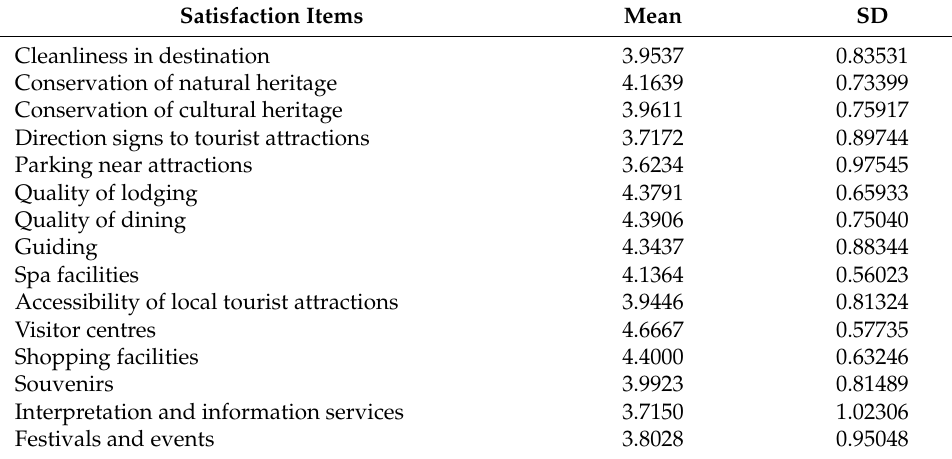
Table 3. Descriptive statistics of satisfaction items.